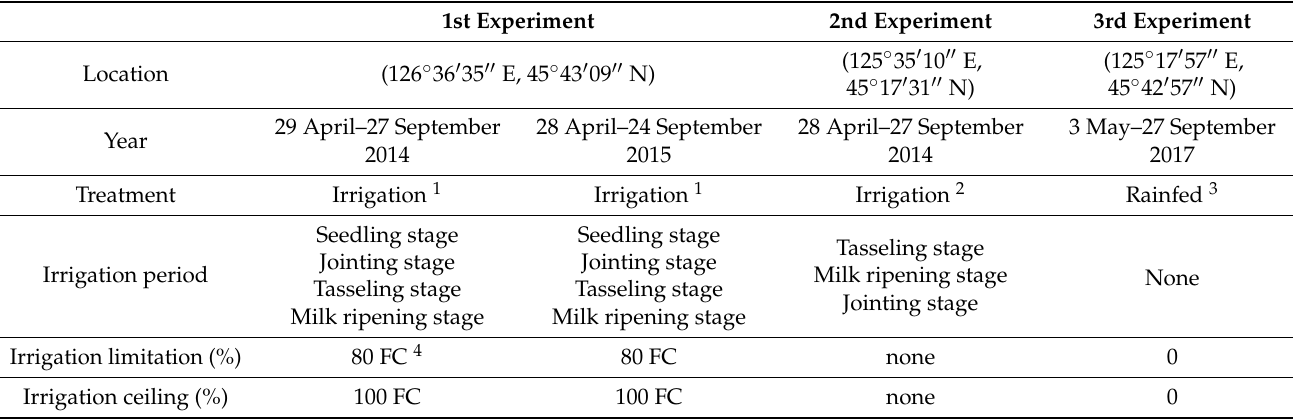
Table 1. Crop management data obtained from three field experiments conducted in Heilongjiang Province, China, and used in the AquaCrop model calibration and verification.